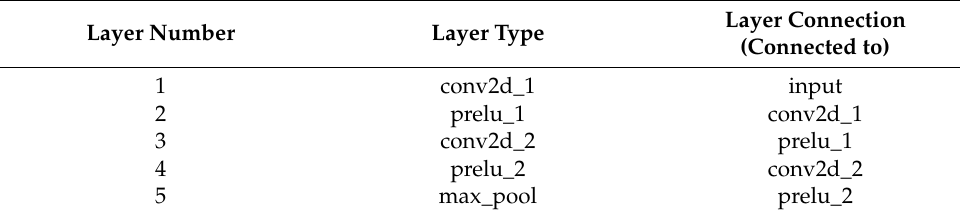
Table 3. Description of an encoder block of the generator